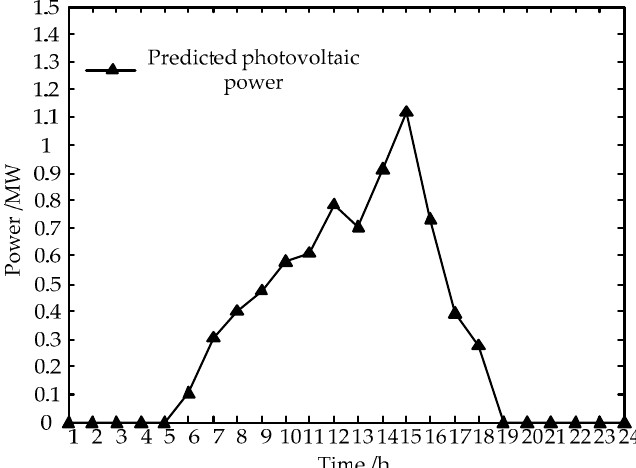
Figure 5. Photovoltaic ( PV) power prediction curve of typical daily E.